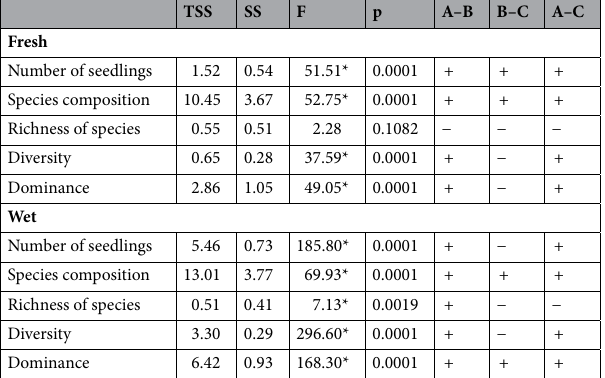
Table 2. Results of one-way PERMANOVA for the soil seed bank; differences in the number of seedlings and in diversity indexes between zones. TSS total sums of square, SS sums of squares, F F value, p p value,